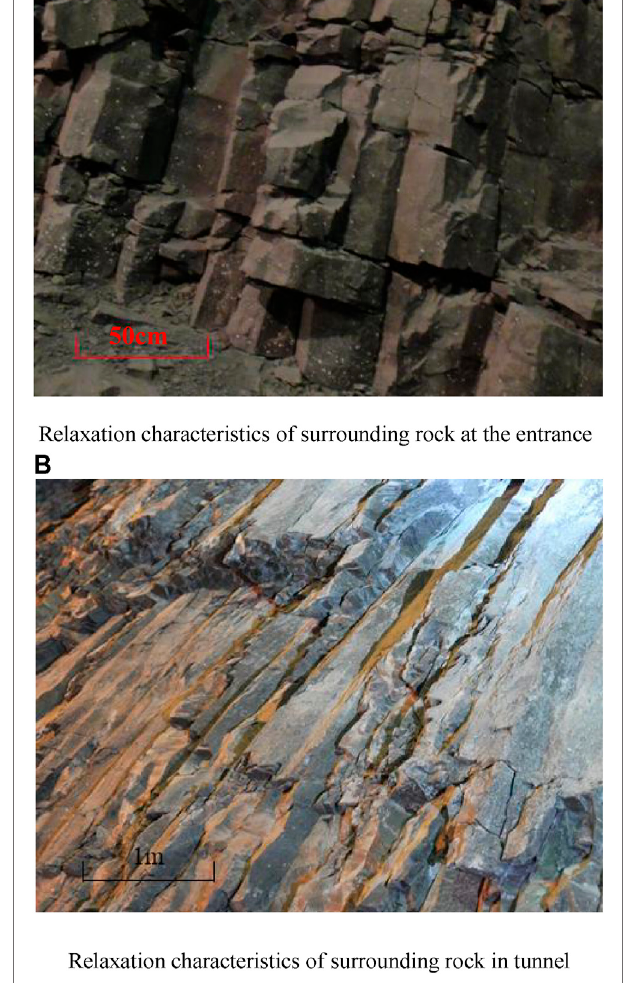
FIGURE4| Comparisonofsurroundingrockrelaxationcharacteristicsin different sections of diversion tunnels. (A) Relaxation characteristics of surrounding rock at the entrance. (B) Relaxation characteristics of surrounding rock in tunnel.